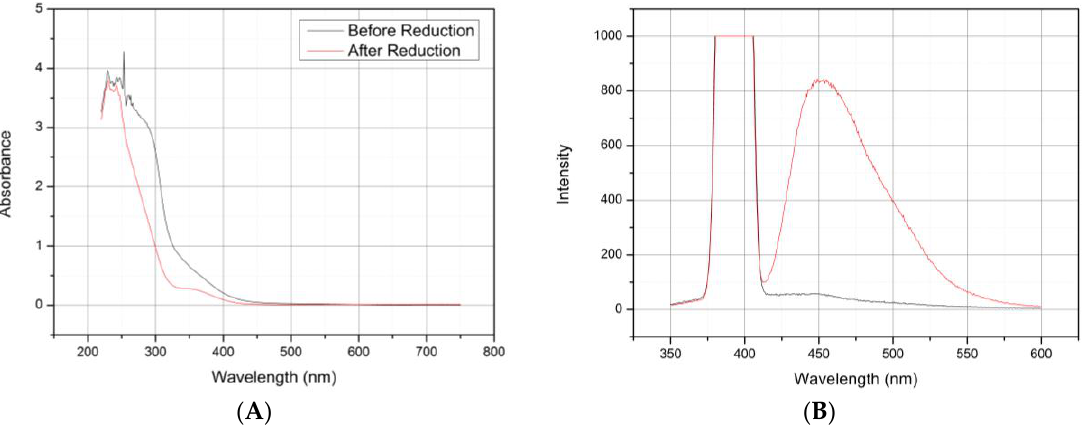
Figure 1. ( A ) UV-Vis scans of the Au/PAMAM G4.0 solution before and after reduction of gold by citrate. ( B ) Fluorescence scans with excitation at 384 nm of the supernatant (red) and resuspended pellet (black) after centrifugation.